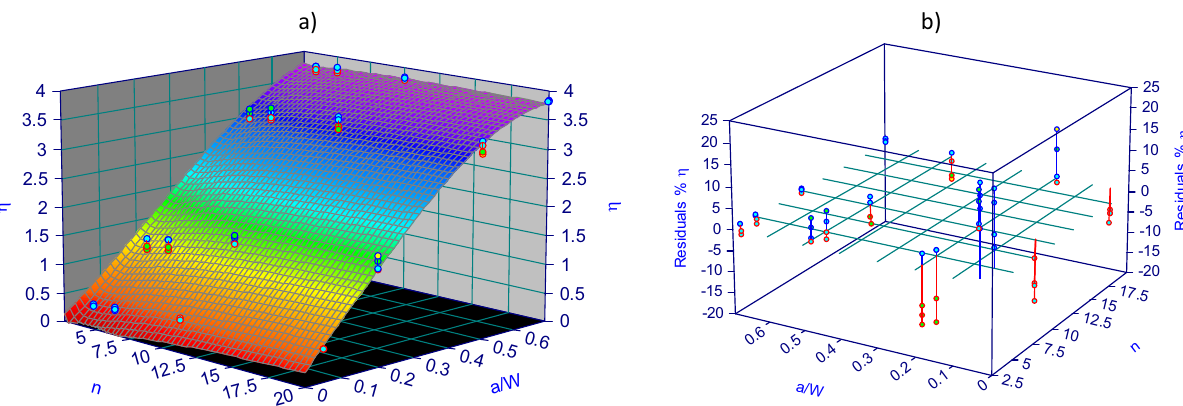
Figure 17: ( a ) Area η = f ( n , a / W ) – a summary of the values of the η coe ffi cient obtained on the basis of numerical calculations and analytical considerations, as a function of the strain hardening exponent n in the R – O law and the relative fracture length a / W ; ( b ) percentage values of residues – the di ff erence between the values of the η coe ffi cient determined on the basis of formula ( 26 ) and on the basis of the numerical and analytical procedure presented earlier on the basis of formulas ( 21 ÷ 25 ) and Figure 16 – the numerical and analytical results are presented in Figure 17a in the form of the η = f ( n , a / W ) surface ( based on refs [ 13,37,38 ]) .